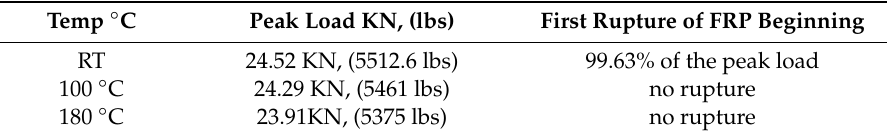
Table 9. Comparison of failure load and first rupture beginning for FRP strengthened concrete beams at RT, 100 ° C and 180 ° C.